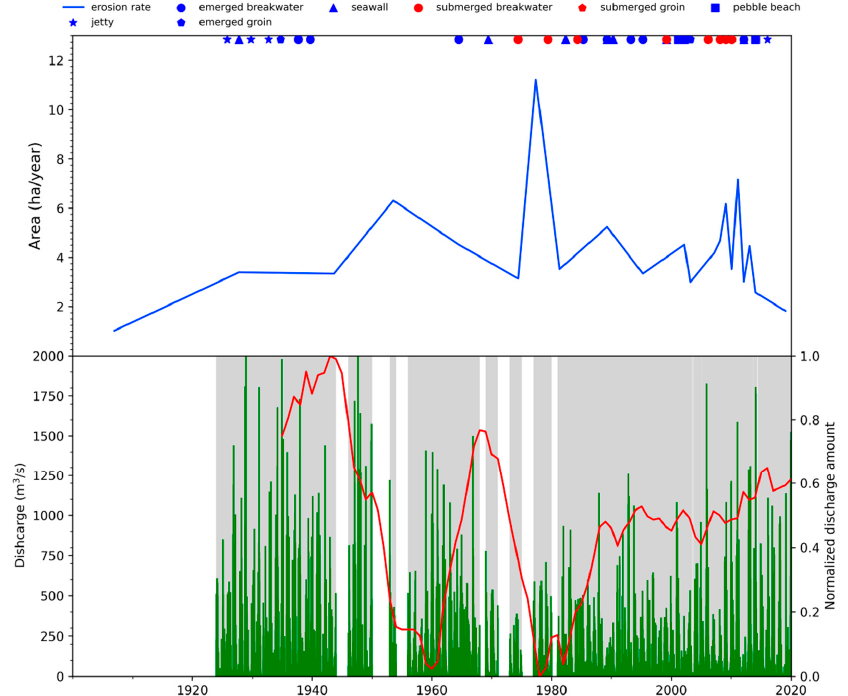
Figure 4. Trend of erosion from 1881 to 2020 of the investigated area (blue line). Top: engineering structures built in the area over time. Daily discharge time series of the S. Giovanni alla Vena gauge data from https://www.sir.toscana.it/consistenza- rete (green bars). The white bars indicate an absence of data. The red line shows the amount of normalized discharge using a moving window of 10